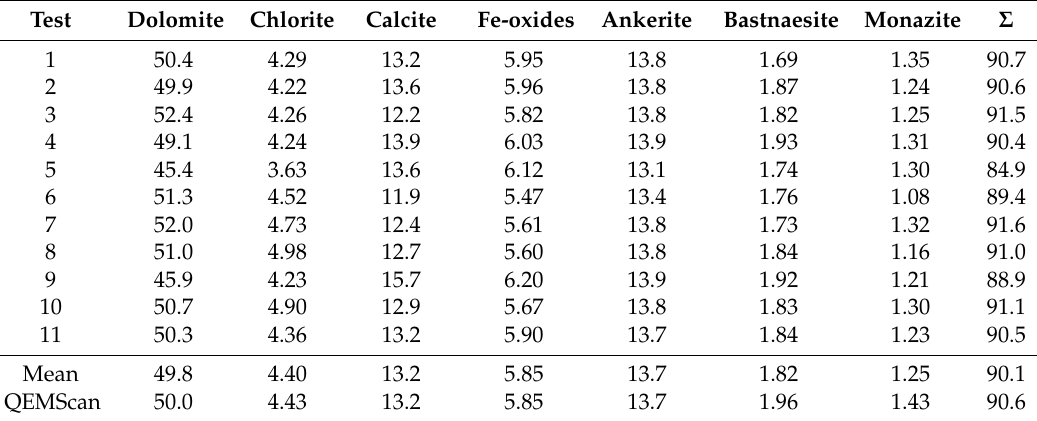
Table 6. Flotation feed mineral compositions (wt